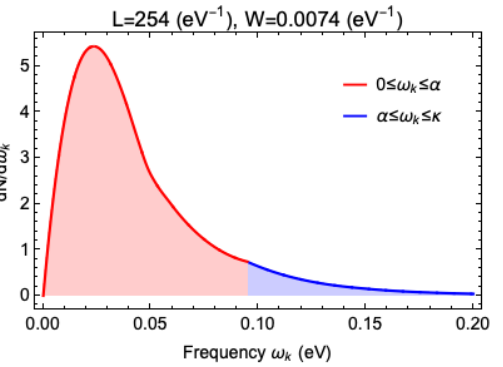
Figure 6. Frequency spectrum of analog Hawking particles [56]. The area shaded in red gives a total number of 0.27 while that shaded in blue gives